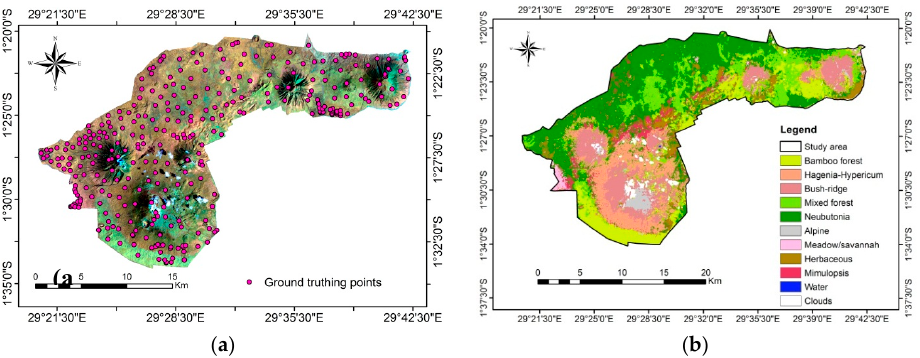
Figure 2. ( a ) Landsat image of the Virunga Volcanoes massif displayed in bands 4 (Near Infrared), 5 (SW Infrared), and 2 (Green), respectively. ( b ) Land cover map representing vegetation cover types and distribution within the Virunga Volcanoes massif.